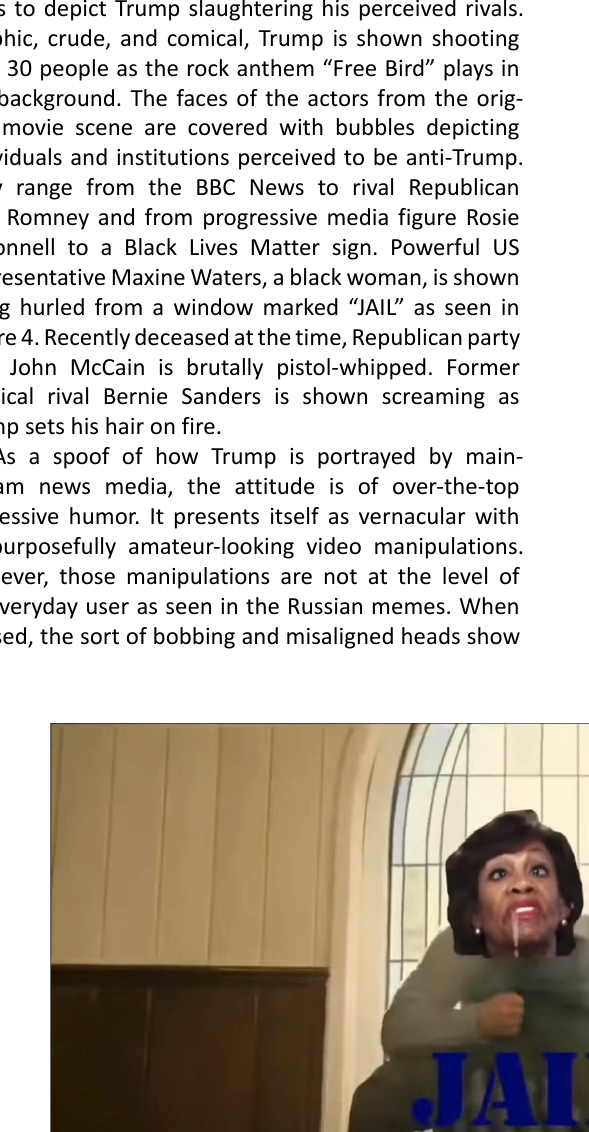
Figure 4. US Representative Maxine Waters depicted as assaulted in “Trumpsmen” video,